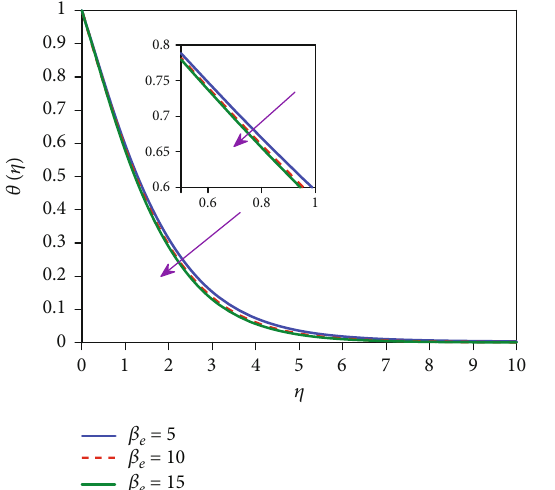
on the concentration ϕ ð η Þ . e